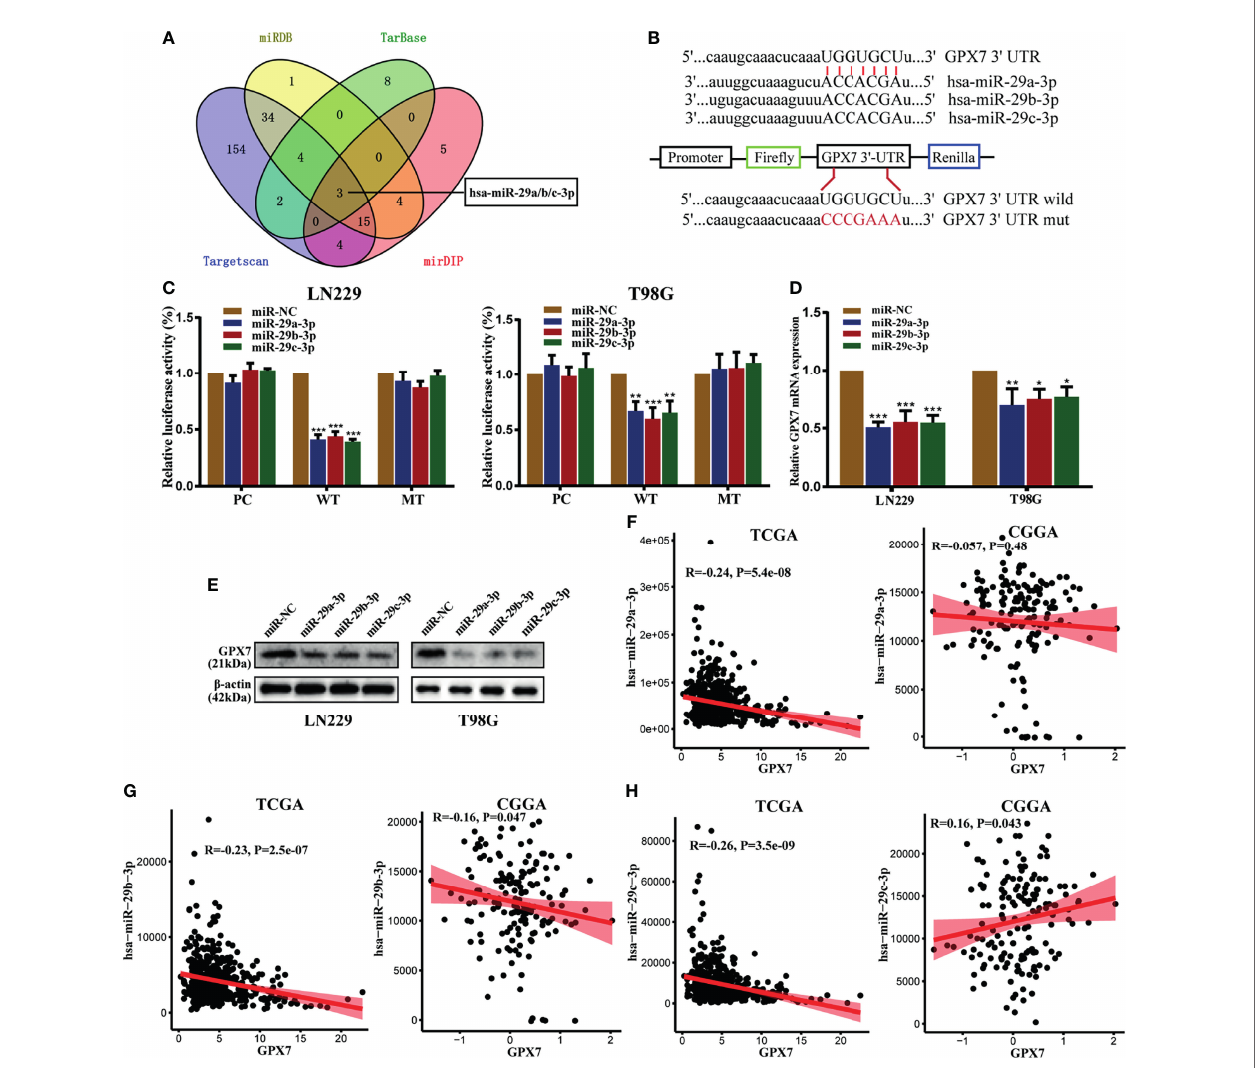
FIGURE 6 | GPX7 is a direct target of miR-29 family. (A) The venn diagram of predicted mRNAs in four different databases. (B) The seed sequences of miR-29 family that match the 3 ′ UTR of GPX7 gene and the reporter vectors containing wild-type or mutant GPX7 3 ’ -UTR. (C) Dual luciferase reporter assays in LN229 and T98G, following cotransfection with miR-29 family and empty vector (pcDNA-3.1) or plasmid containing wild or mutant type 3 ′ UTR of GPX7. (D, E) The mRNA and protein levels of GPX7 in cells transfected with miR-29 family mimic or miR-NC. (F – H) The correlations between GPX7 expression and miR-29 family in TCGA